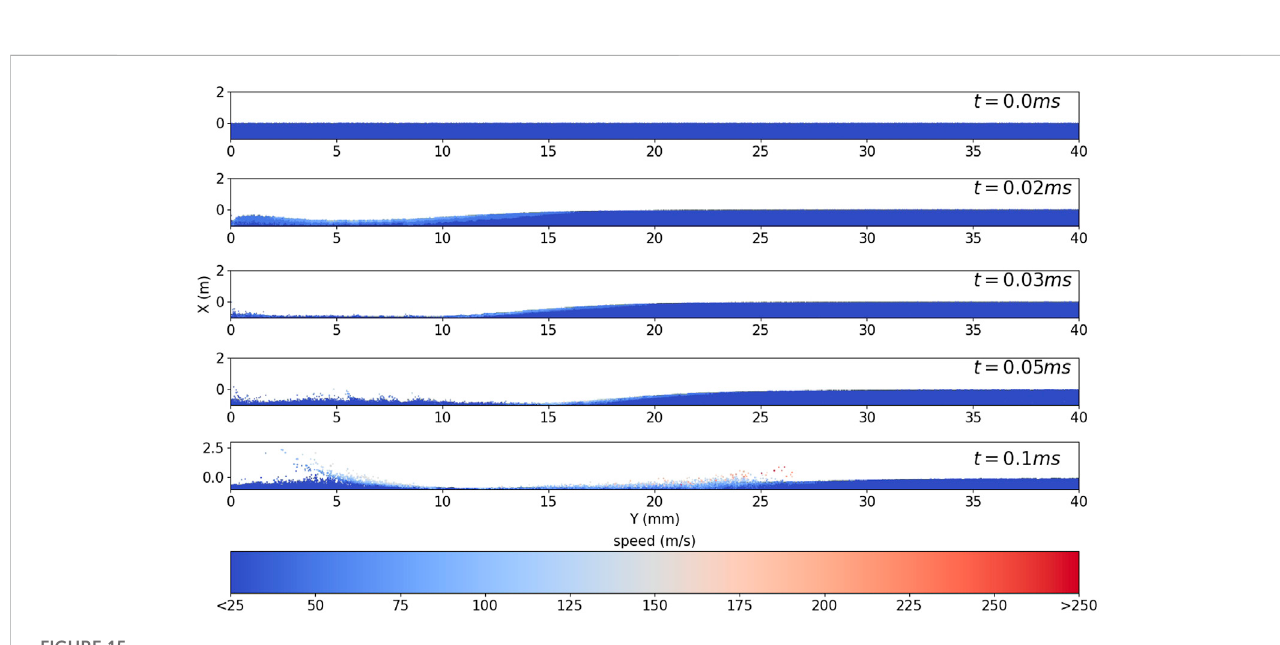
Comparison of physical properties along the symmetry axis for the MPPIC and stochastic collision model cases.